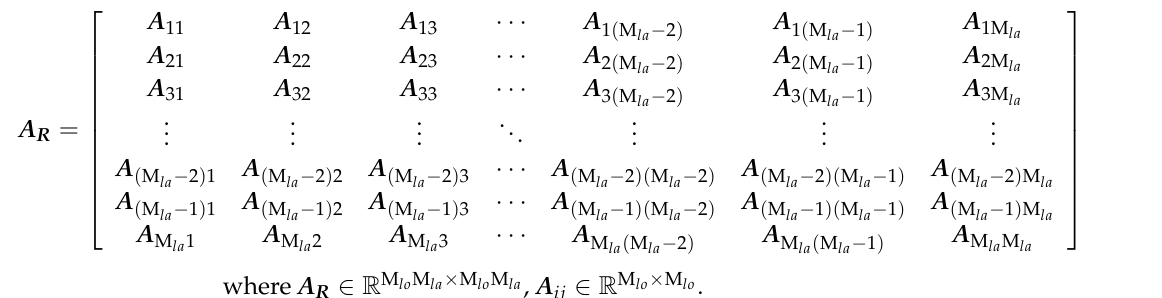
Figure 5. Recognition performance digraph. The adjacency matrix corresponding to the recognition accuracy of the directed graph